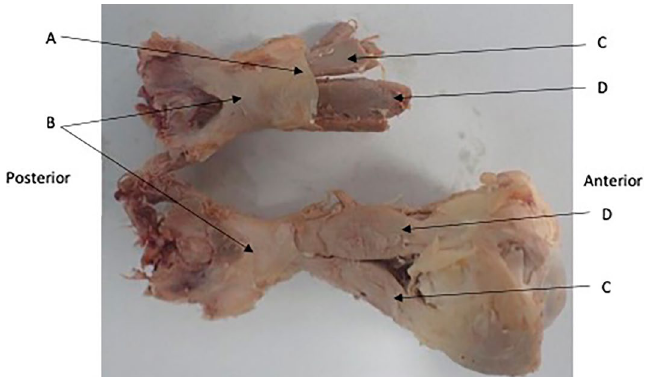
Figure 7. Dural Sheath (A) shown continuing into the orbit anteriorly and posteriorly to unite with the common tendinous origin. Lateral Rectus (C), Inferior Rectus